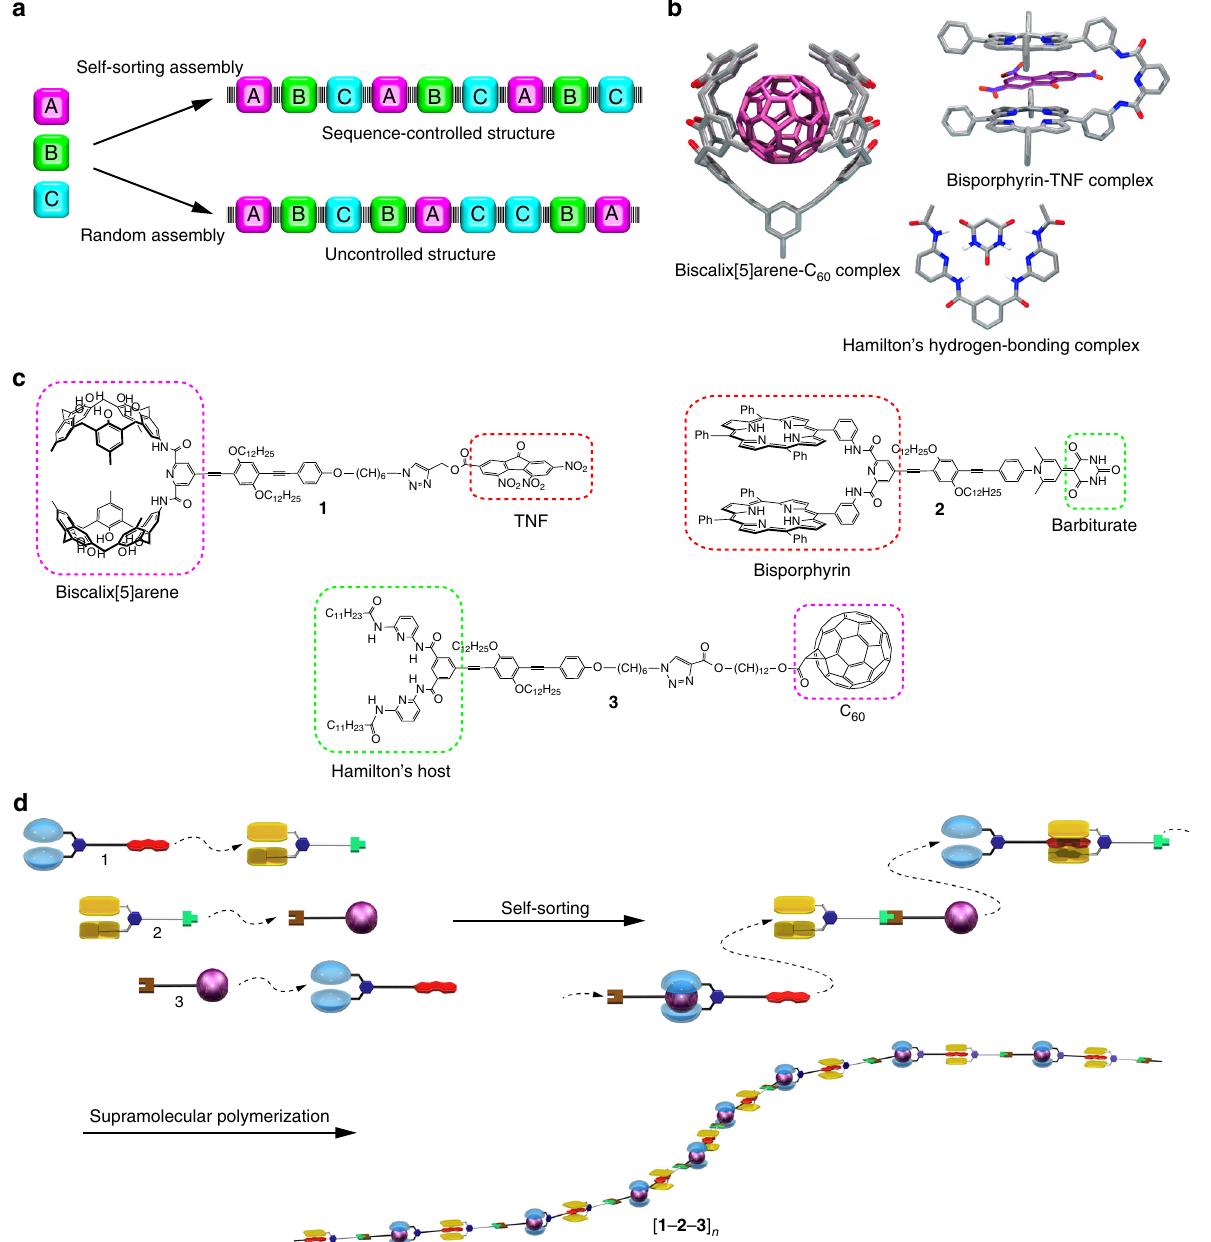
Fig. 1 Supramolecular terpolymerization. a Schematic representation of the supramolecular terpolymerization of three components A, B, and C via self-sorting assembly or random assembly. b Host – guest structures of the biscalix[5]arene-C 60 complex, bisporphyrin-TNF complex, and Hamilton ’ s hydrogen-bonding complex. c Structures of the three heteroditopic monomers 1 , 2 , and 3 possessing mismatched host – guest pairs. d Sequence-controlled supramolecular polymerization of three sets of heteroditopic monomers via a